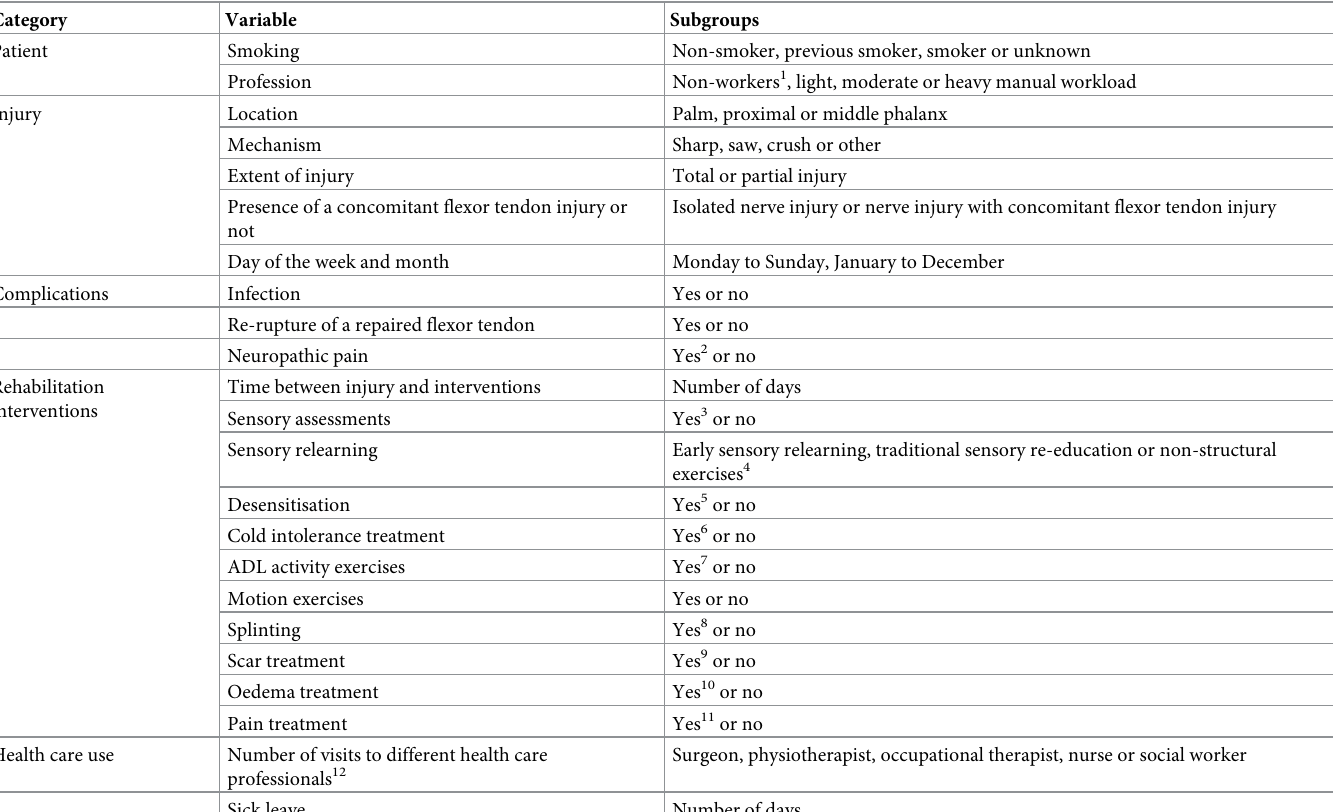
Table 1. Patient and injury data collected from medical records in Stockholm, Sweden,